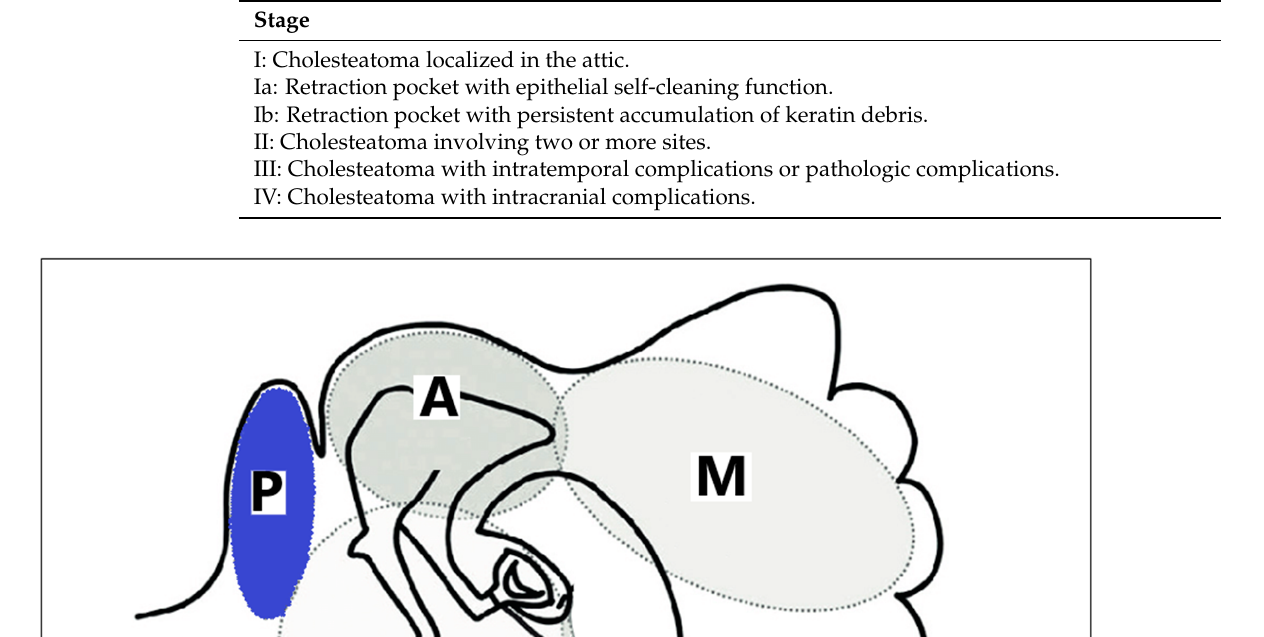
Table 1. Japan Otological Society classification of cholesteatoma stages (adapted from Tetsuya Tono et al., 2017 [1]).